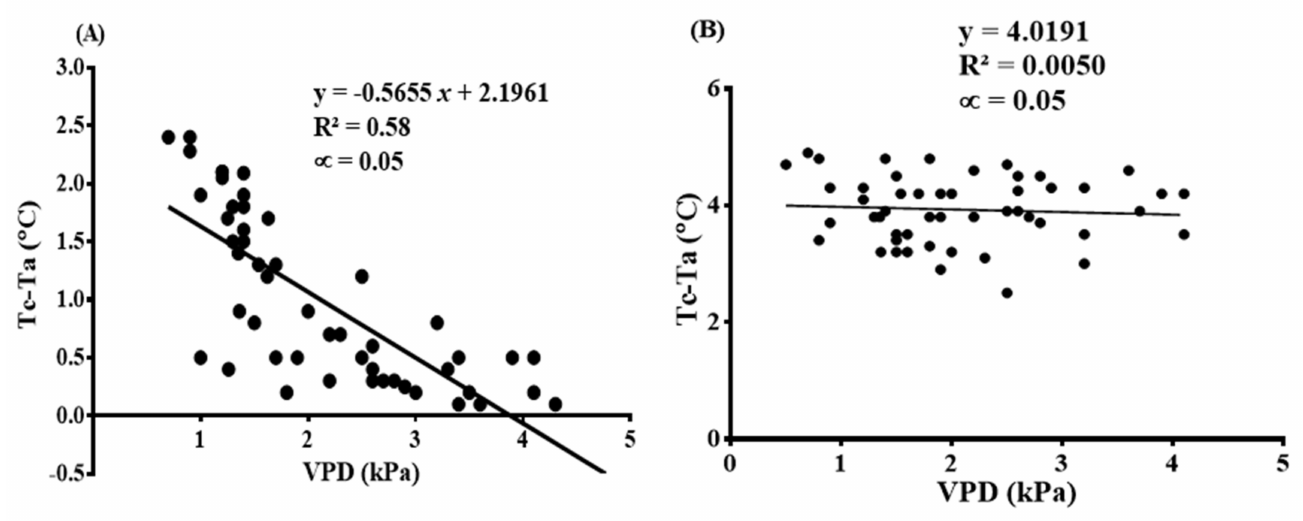
Figure 6. Relationship between T c − T a ( ◦ C) and VPD (kPa) for developing ( A ) non-water stressed and ( B ) non-transpiring baseline reference points in relation to fully irrigated and extremely stressed mandarin trees at noon on a very bright, clear day. The computed seasonal CWSI (Idso) values ranged from − 0.21–0.79, with average seasonal values of 0.14, 0.33, 0.48, and 0.61 recorded for treatments 80–100% FC, 70–75% FC, 60–65% FC, and 50–55% FC, respectively, in summer, while the average seasonal values for autumn were 0.16, 0.32, 0.46, and 0.58 for the treatments 80–100% FC, 70–75% FC, 60–65% FC, and 50–55% FC, respectively. These values are shown in Figure 7A,B.